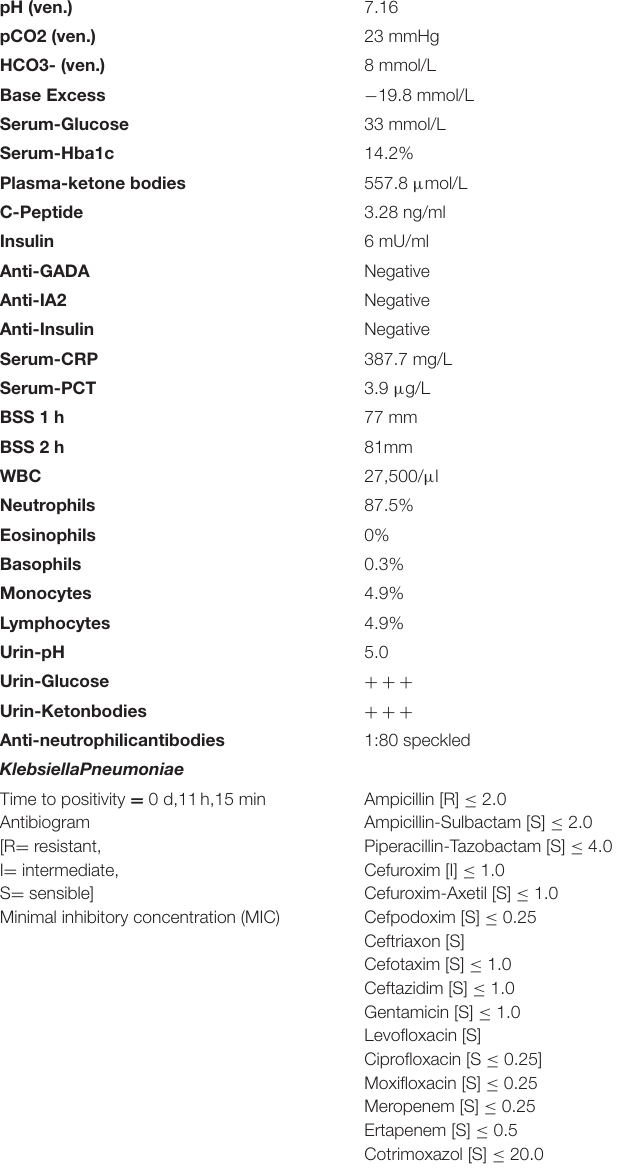
TABLE 1 | Blood parameters at